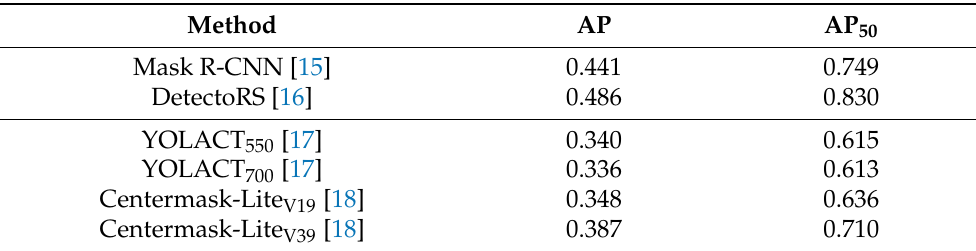
Table 4. Generalisation mask AP results per model, the first two rows are robust methods and the rest are real-time capable methods. All the classes have been contemplated as a single class